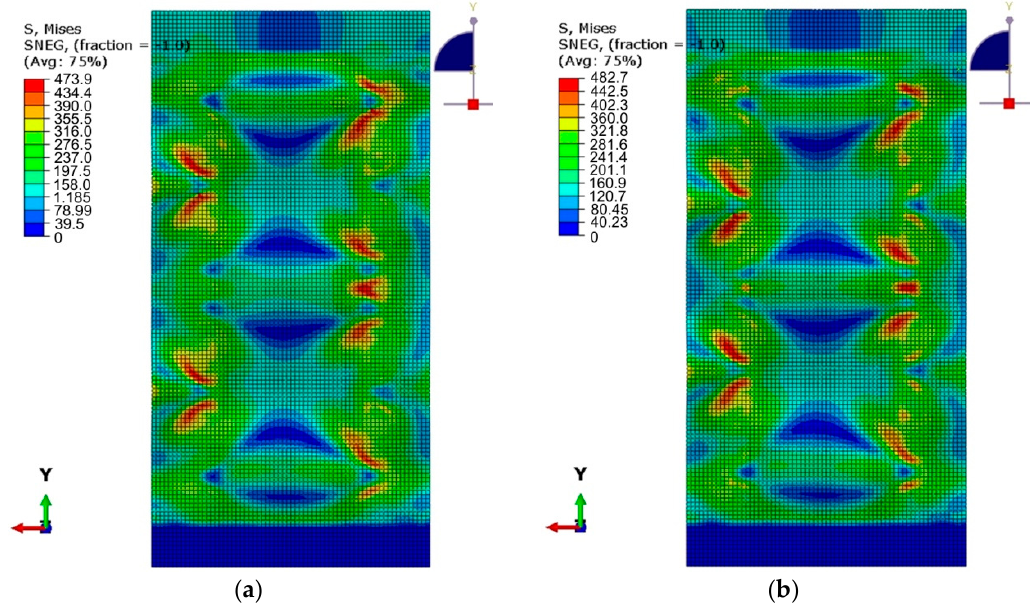
Figure 14. Comparison of equivalent plastic stress on the outside of a stiffened panel subjected to a compressive force of 0.75 F max : ( a ) welded variant ( s = 29.5 mm), ( b ) riveted variant ( s = 23.5 mm).